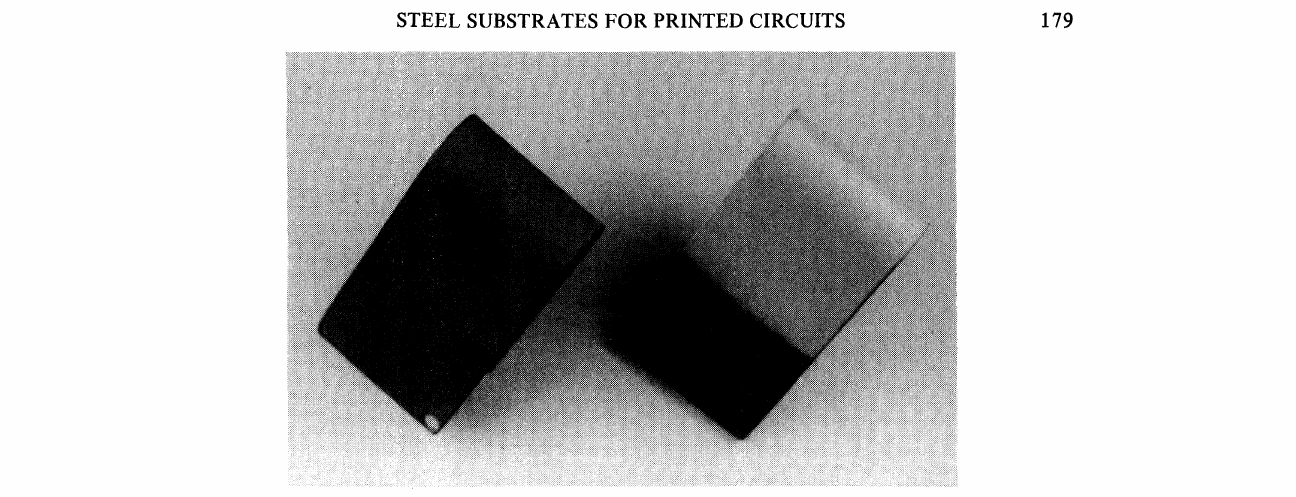
FIGURE 3 Steel sheets coated with a ground coating and also with a varnish and then